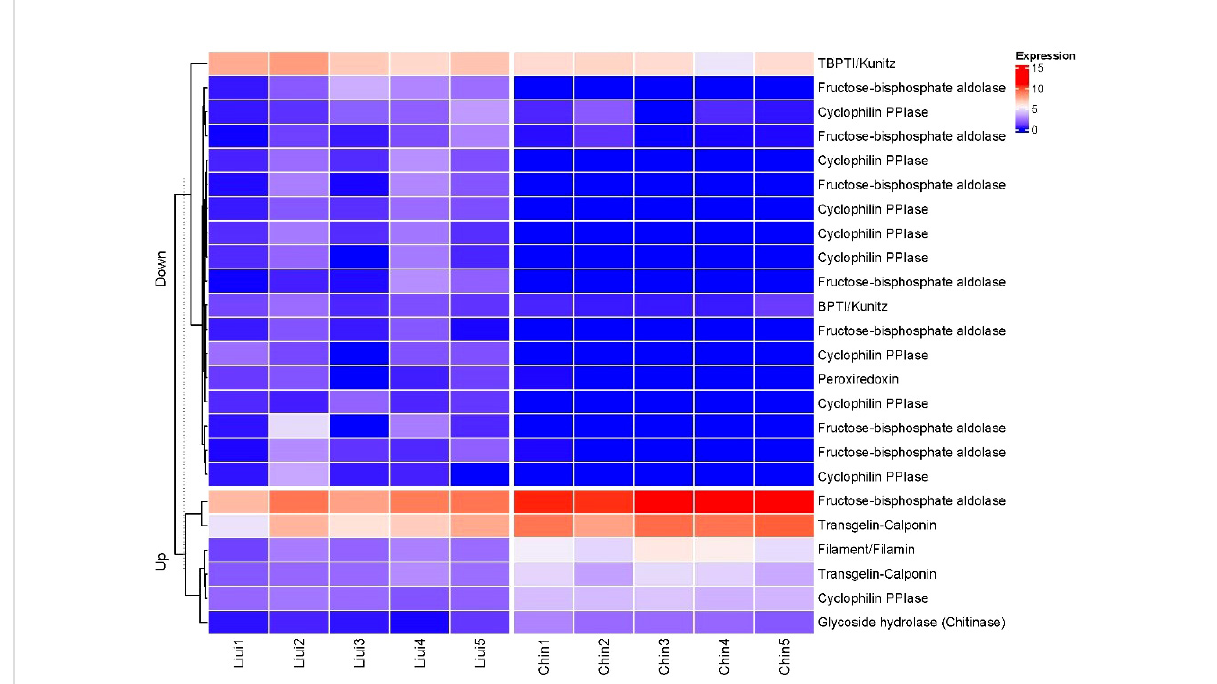
FIGURE 8 Heatmap of the hierarchical clustering showing the pro fi les for the SMP-related differentially expressed genes. Expression: log 2 (FPKM+1); Up, upregulated genes in Sternaspis chinensis vs . Sternaspis liui syn. n; Down, downregulated genes in S. chinensis vs . S. liui syn. n; Liui1 – 5, specimens of S. liui syn. n; Chin1 – 5, specimens of S. chinensis